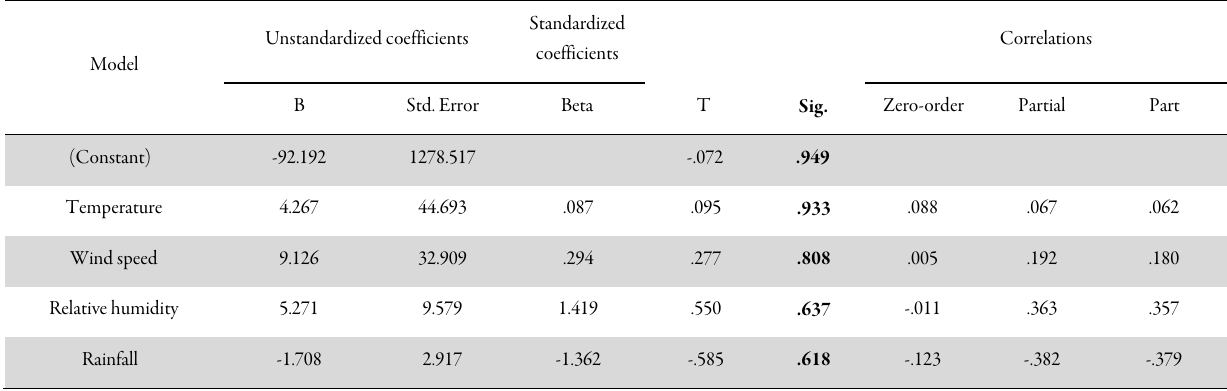
Table 8. Correlation coefficients showing the significance levels in the correlation between monthly pollen concentrations and values of mean monthly meteorological parameters at the study site in Sokoto state at 95% confidence interval (P <